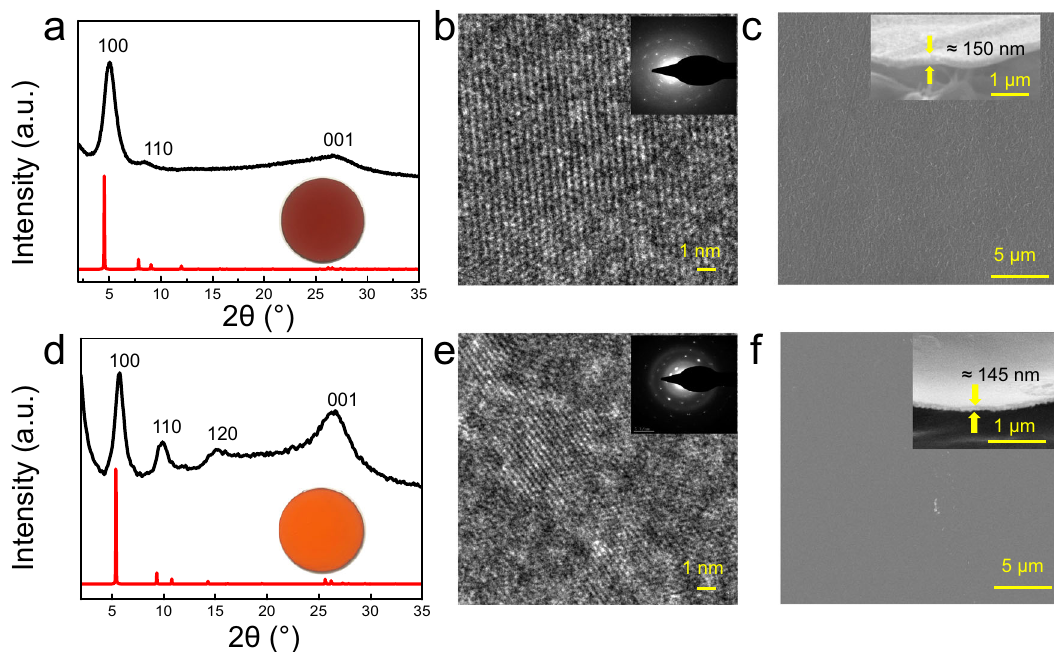
Fig. 2 Structural characterization. a , d XRD pattern, experimental (black line) and simulated (red line), digital photos of the COF membranes on the support are also shown. b , e HR-TEM images and SAED patterns. c , f Surface and cross-section SEM of the TFP – PDA, TFP – TTA,